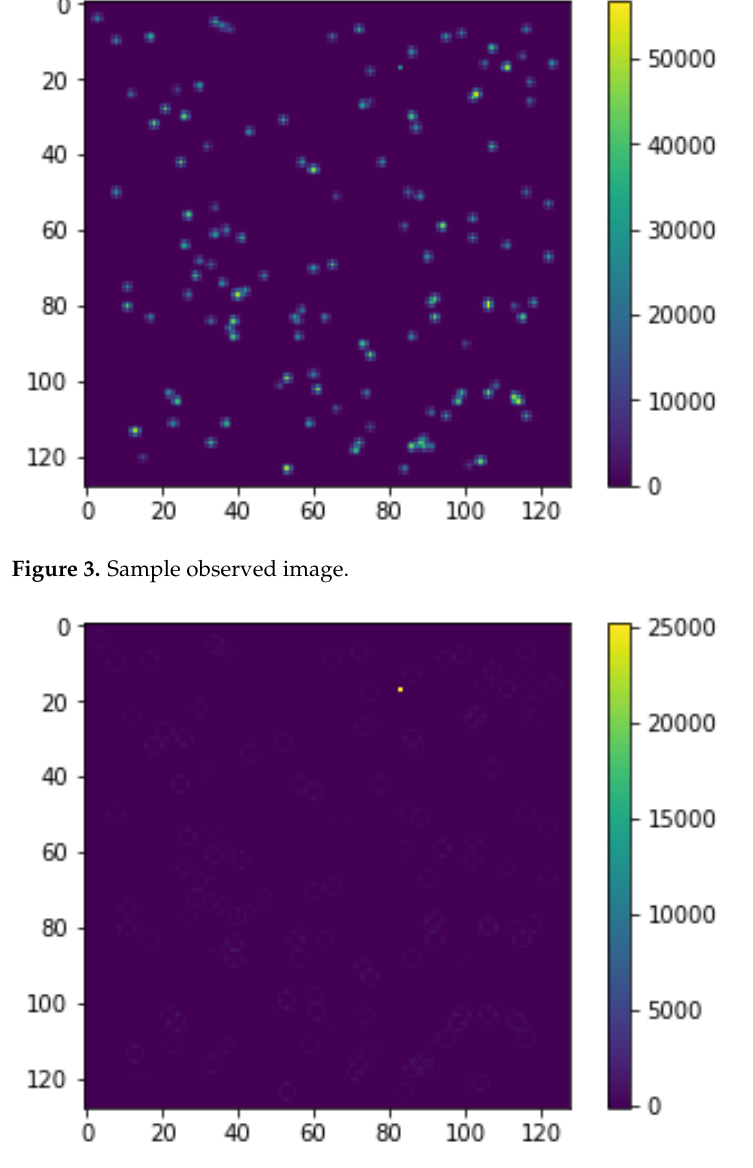
Figure 4. Sample differenced